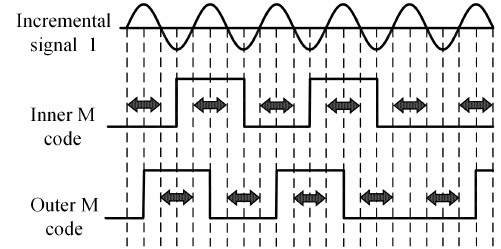
Figure 2. Reading relationship between incremental signal and M-code